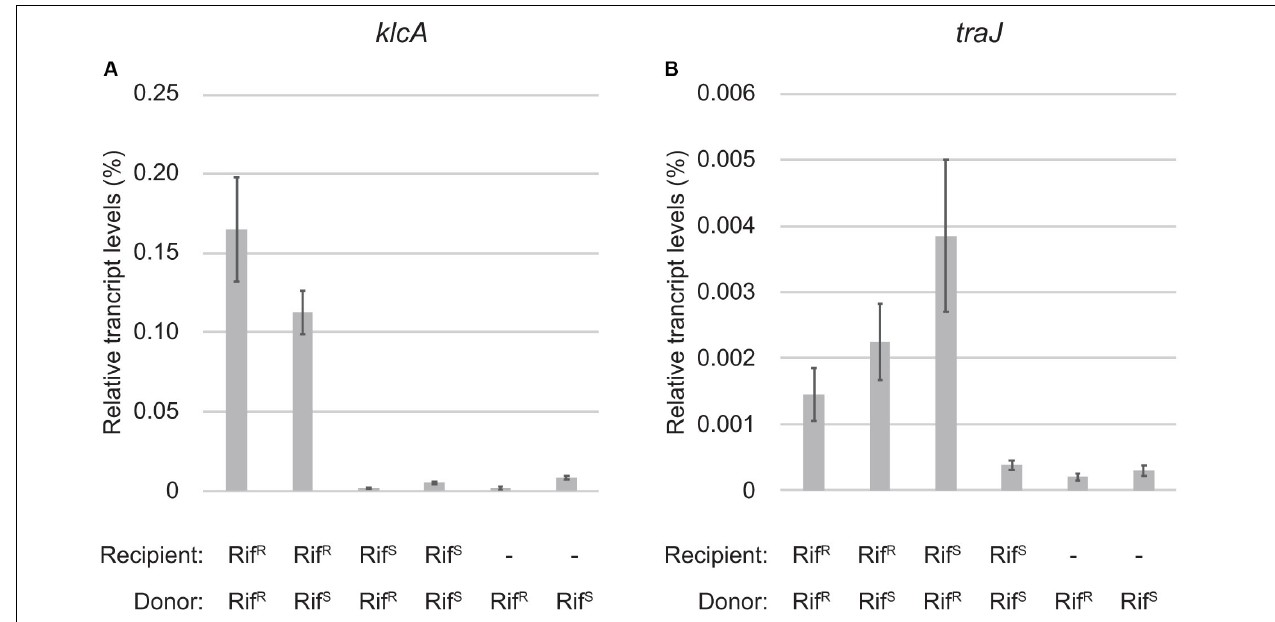
FIGURE 3 | Quantitative RT-PCR analysis of zygotic induction. The transcript levels of klcA (A) and traJ (B) mRNAs relative to 16S rRNA are shown. The combinations of Rif R and Rif S strains for donor and recipient of RP4 are indicated below. The two bars on the right are control samples of donor cells